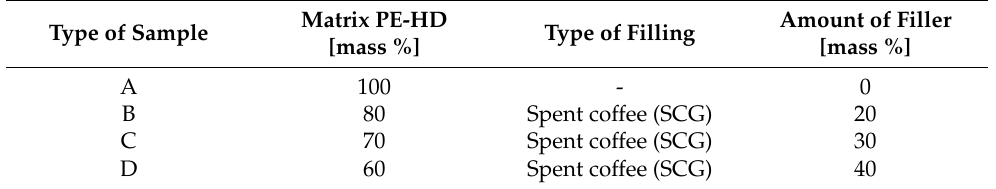
Table 1. Composition of the tested samples.